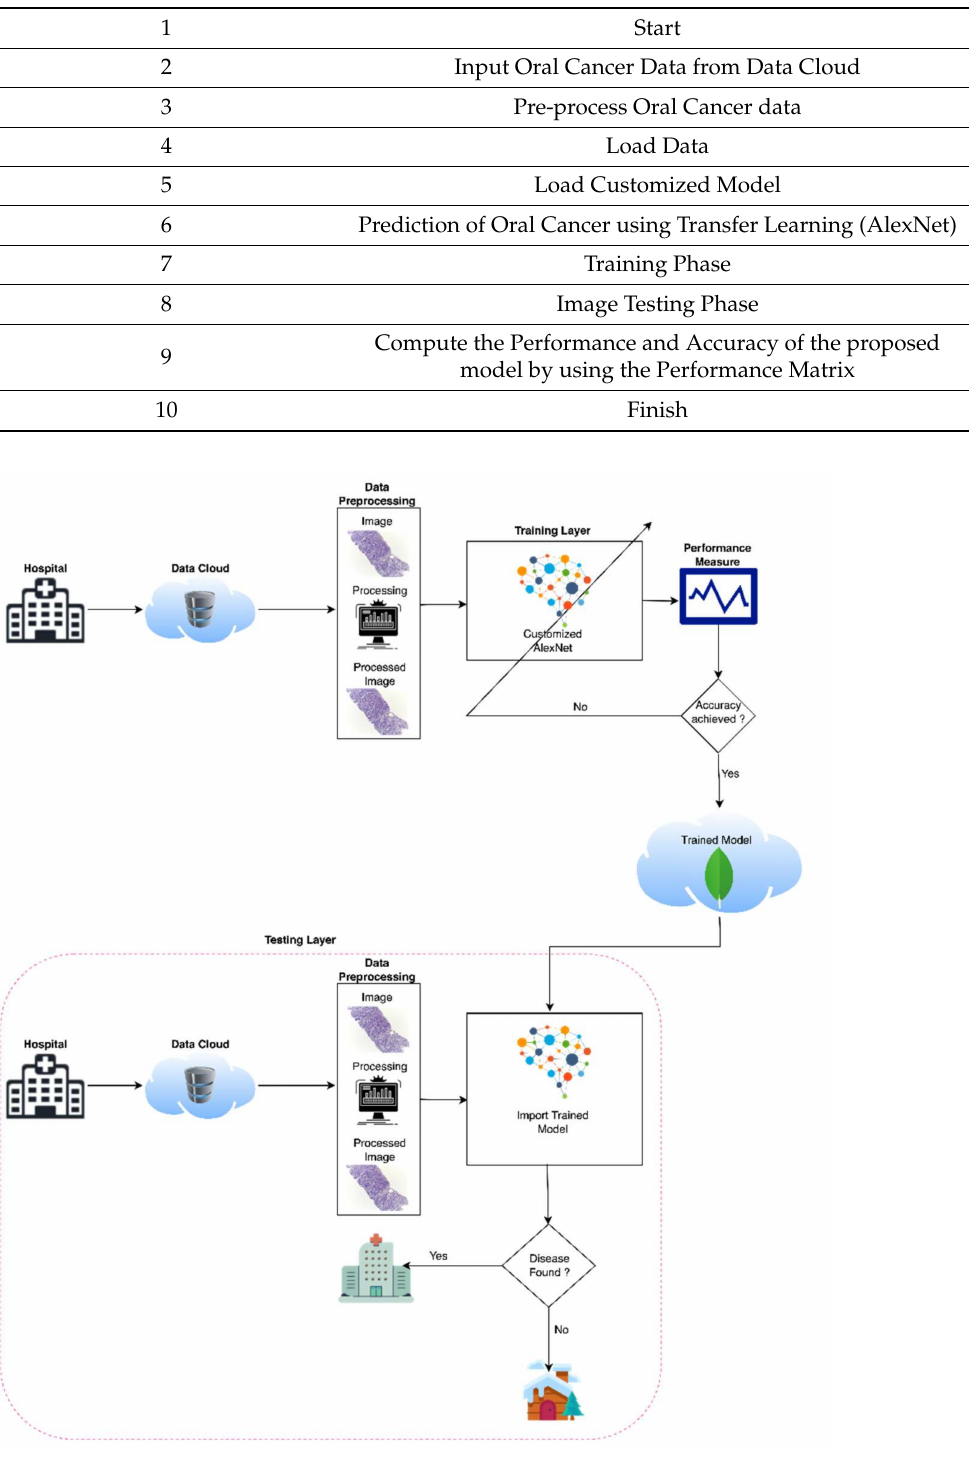
Figure 1. Proposed model of oral cancer prediction empowered with transfer